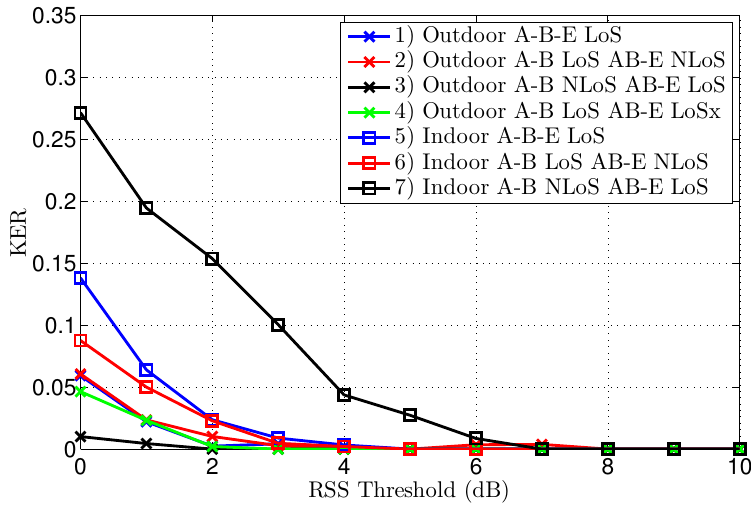
Figure 7. Key Error Rate after reconciliation for different threshold levels, for all scenarios.